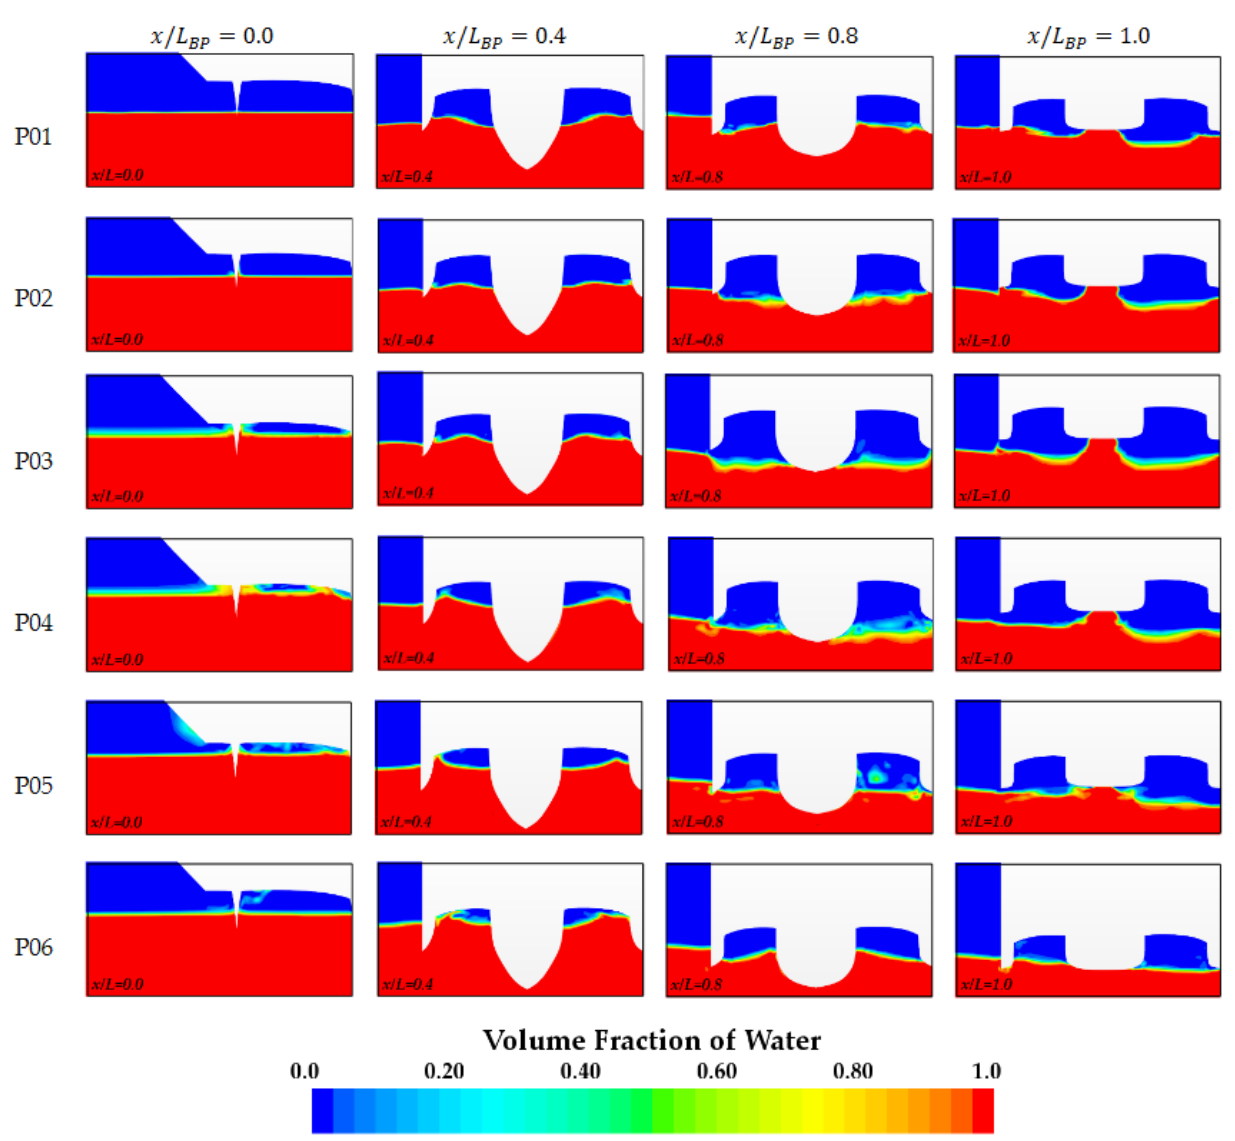
Figure 16. The air-water distribution through the tunnels of the Double-M craft at each YZ section for the different regular wave conditions.